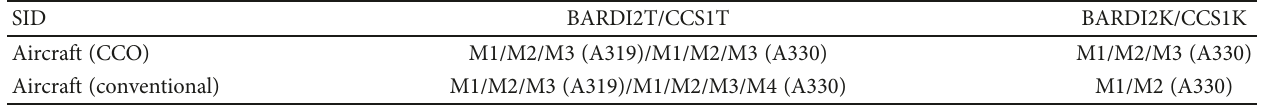
Table 3: Aircraft types and their associated mass ( M ) per SID for optimal CCOs and conventional